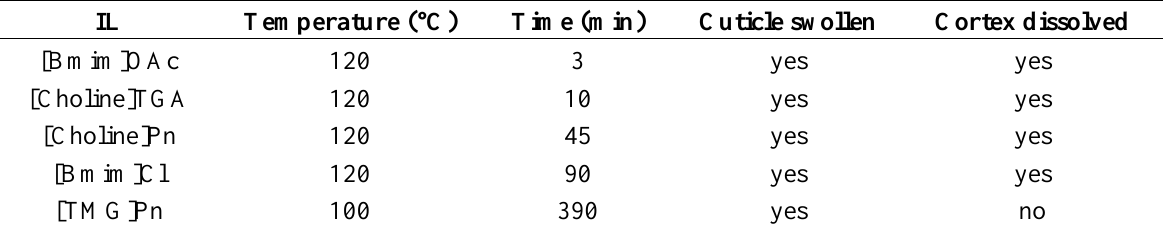
Table 1. Observed dissolution times and temperatures of single wool fibre tests in various ionic liquids (ILs).